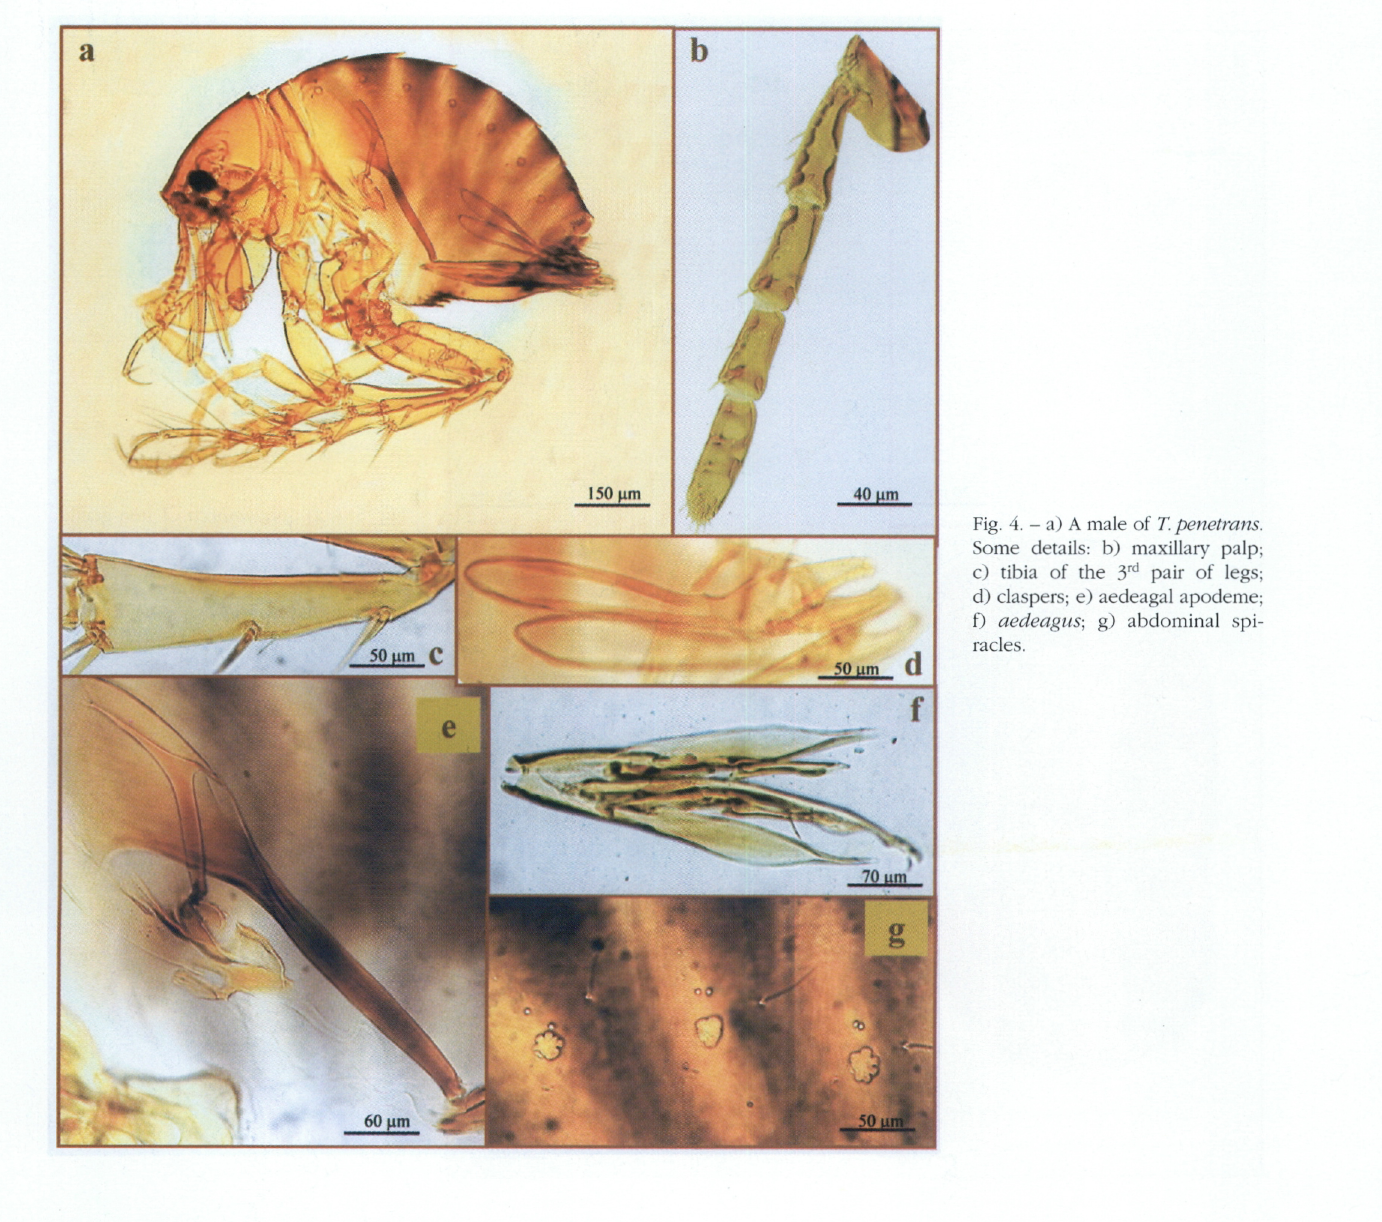
Fig. 4. - a) A male of T. penetrans. Some details: b) maxillary palp c) tibia of the 3rd pair of legs d) claspers; e) aedeagal apodeme f) aedeagus ; g) abdominal spi